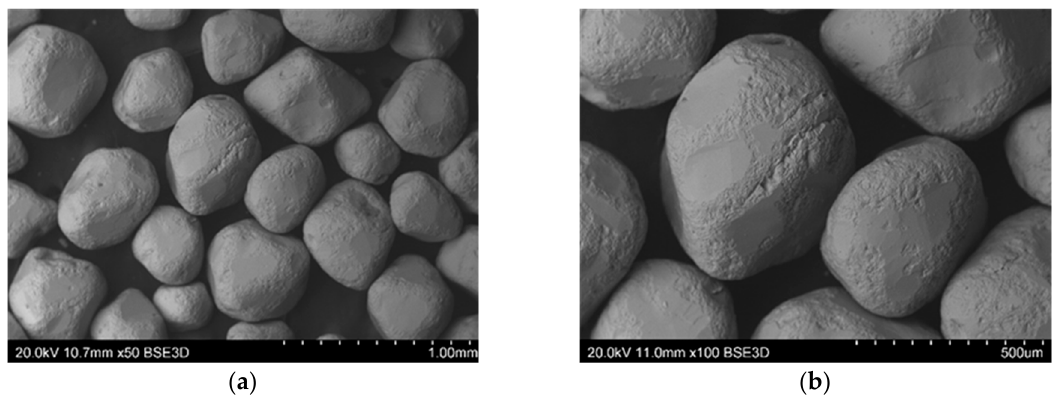
Figure 19. BSD images from the scanning electron microscope of the mechanical reclaimed material after 15 min of treatment of the used sand on the RM15M100 chromite matrix: ( a ) mag. 50×, ( b ) mag. 100×.